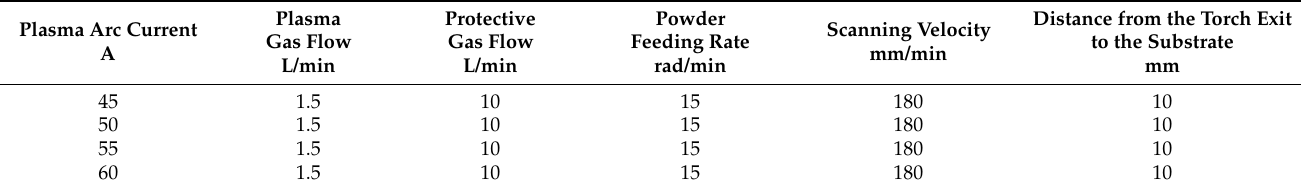
Figure 3. PTA cladding system schematic and sample preparation. Table 3. Plasma cladding parameters.